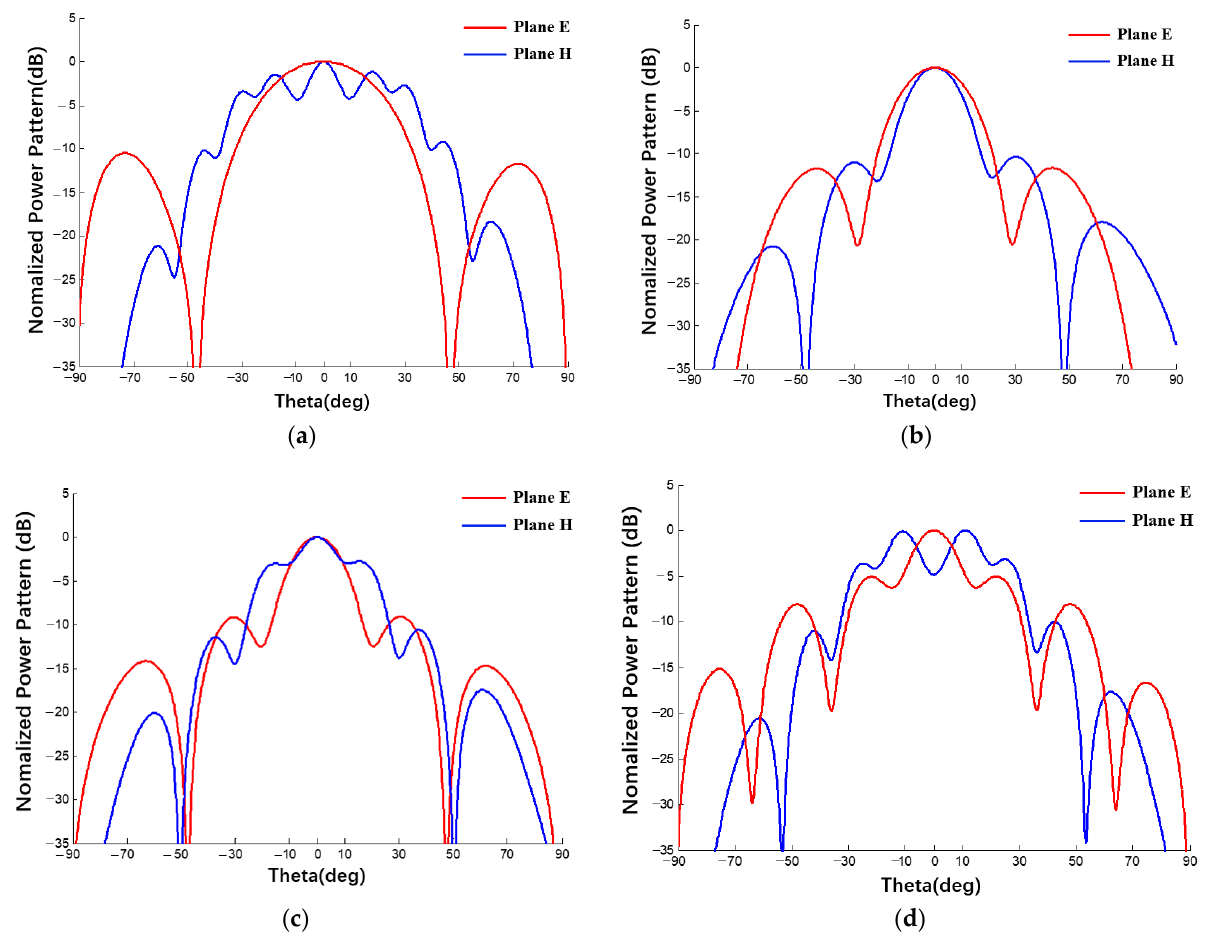
Figure 24. Power patterns of spherical conformal array antennas with different specifications: (uni- form excitation, ( a ) 2 × 10, ( b ) 3 × 4, ( c ) 4 × 6, ( d ) 5 × 8).